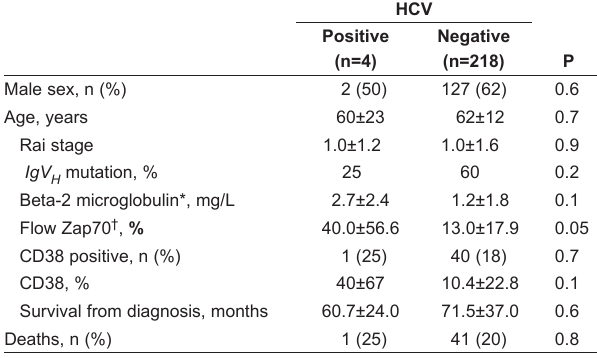
Characteristic (normal range)